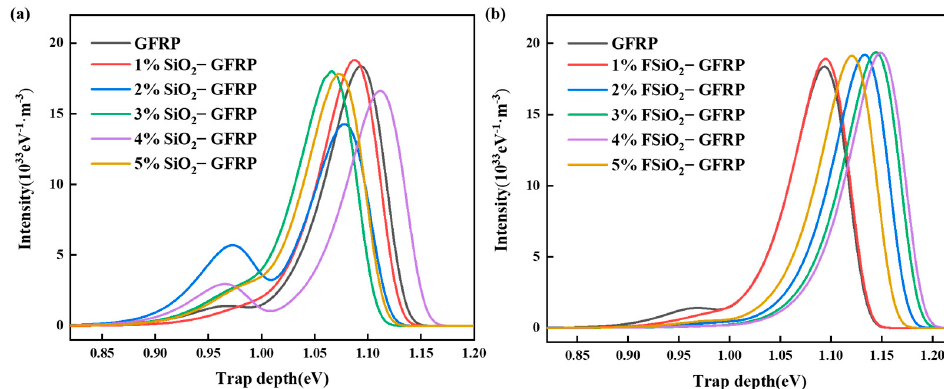
Figure 8 . Trap energy level and density distribution of GFRP. ( a ) SiO 2 -GFRP. ( b ) FSiO 2 -GFRP. Figure 8. Trap energy level and density distribution of GFRP. ( a ) SiO